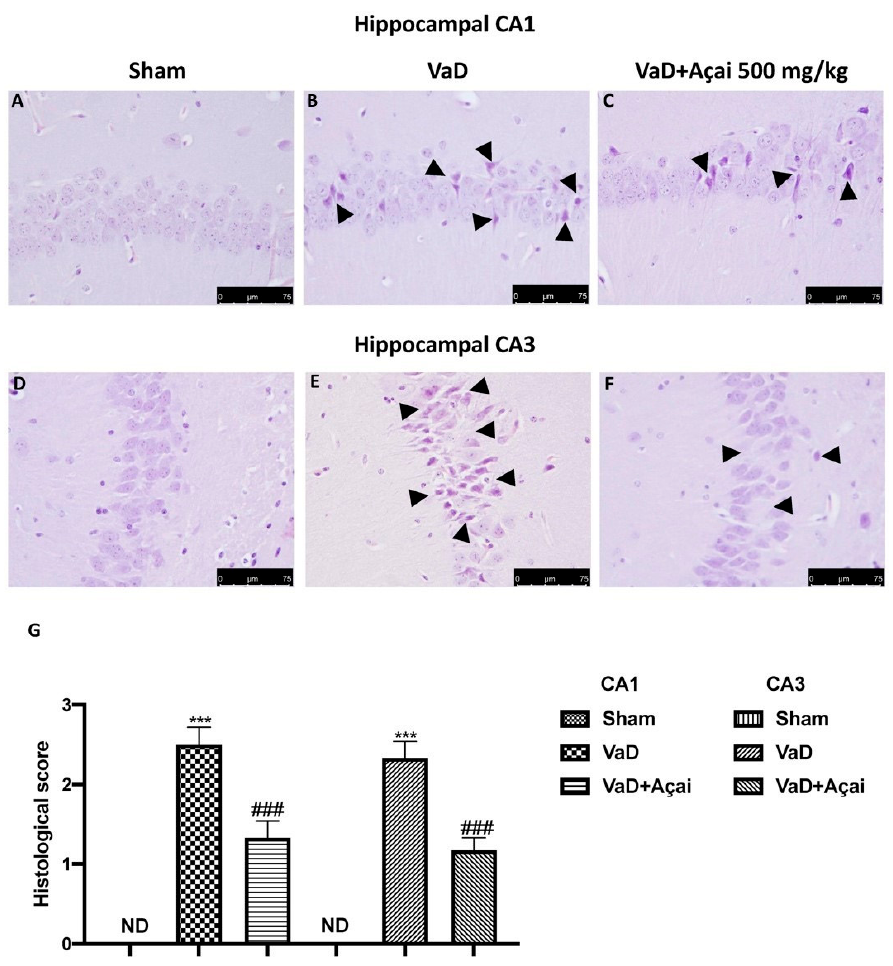
Figure 2. Açai berry limits vascular-dementia-induced histological changes. Hippocampal CA1 figure of Sham ( A ), VaD ( B ), Açai Berry ( C ); Hippocampal CA3 figure of Sham ( D ), VaD ( E ), Açai Berry ( F ); Histological score ( G ). Arrows indicate altered neurons and loss of hippocampal architecture. Figures are representative from least three experiments. Values are means ± SEM of six mice for all groups. See manuscript for further details. *** p < 0.001 vs. sham; ### p < 0.001 vs.